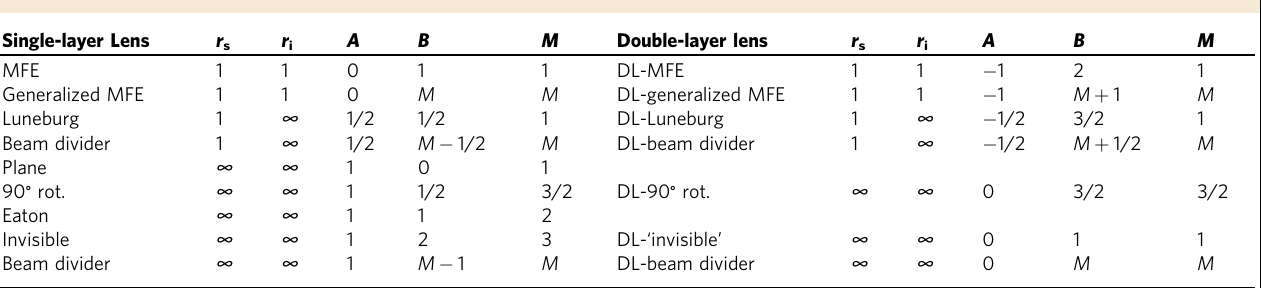
Fig. 4 Double-layer lenses with both foci r = 1. From an initial point source at r s = 1, ϕ = π we trace the ray motion through the pro fi les de fi ned through the implicit Eq. (30). To aid visualization we plot the rays launched in the + y direction as dashed lines, and those launched in the − y direction as solid lines. We give four examples, where the turning angle Δ ϕ is π plus a π /2; b 3 π /4; c π ; and d 3 π /2. When M is integer, the lens has the functionality of a ordinary (for even numbers) or double-layer (for odd numbers) Maxwell Fish Eye lens, while otherwise, it acts as a Generalized Fish Eye, where two foci appear on the rim. Table 1 Comparison between double-layer and single-layer lenses. Single-layer